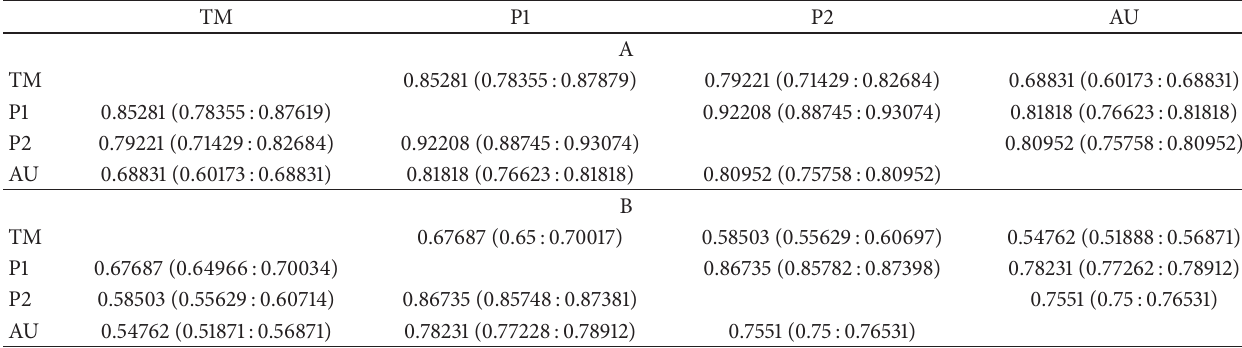
Table 3: The results of the pairwise agreement analysis of data, without taking into account categorical information produced using Kendall’s tau-b analysis for interobserver variability on the WSI from sets A and B separately: TM means classical expert microscopic review, P1 and P2 mean pathologists, and AU means proposed automatic